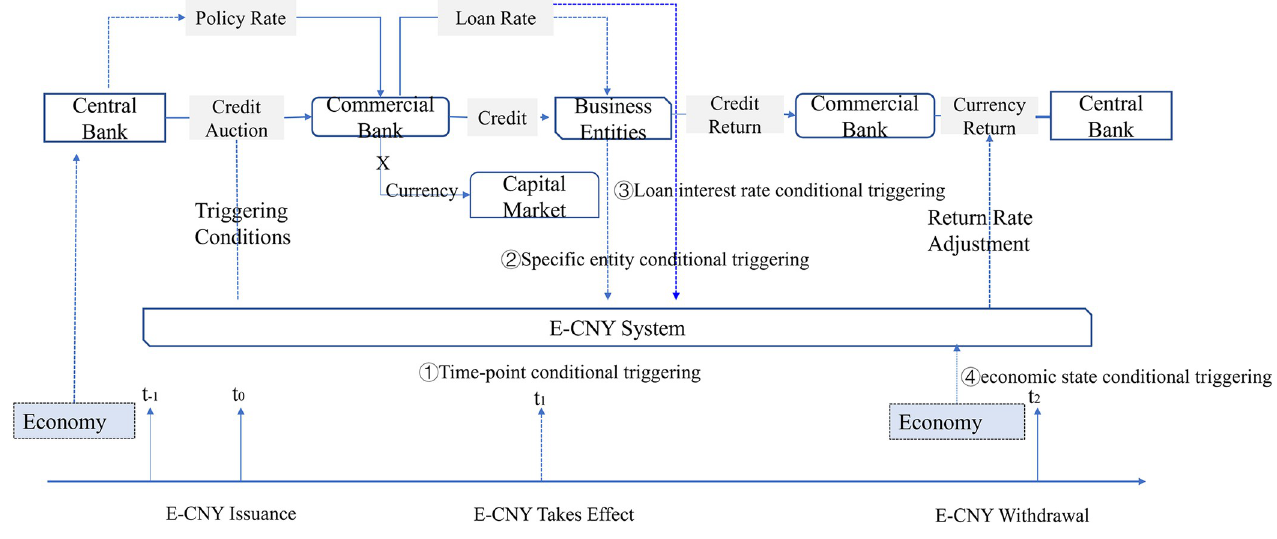
Fig 13. Schematic diagram of the four triggering conditions.